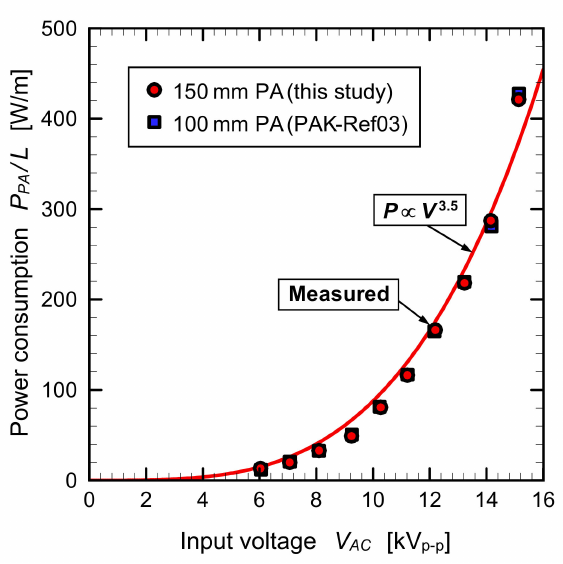
Figure 8. Power consumption of plasma actuator.